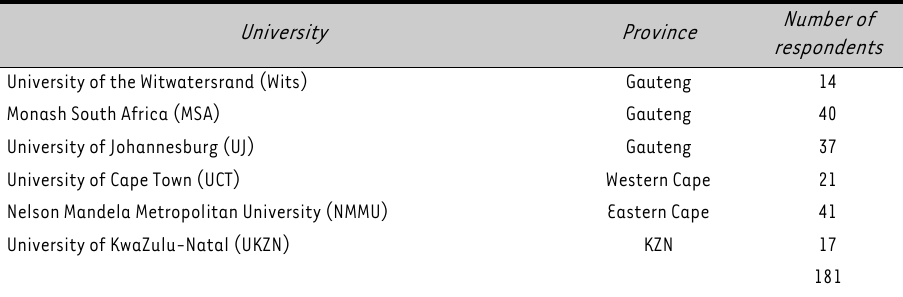
Table 2: Universities selected for the